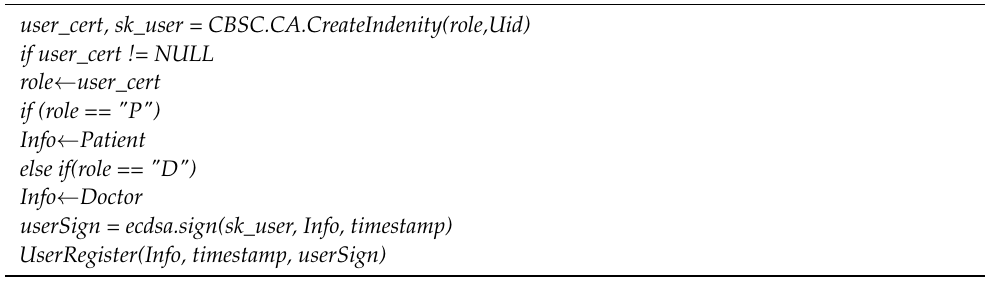
Algorithm 1 . The chaincode pseudo-code of the user registration information. Algorithm 1. The chaincode pseudo-code of the user registration information.